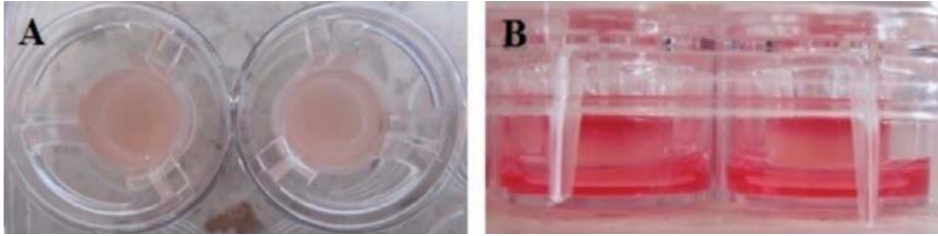
Figure 1- (cid:36)(cid:17)(cid:3)(cid:36)(cid:76)(cid:85)(cid:16)(cid:79)(cid:76)(cid:84)(cid:88)(cid:76)(cid:71)(cid:3)(cid:87)(cid:72)(cid:70)(cid:75)(cid:81)(cid:76)(cid:84)(cid:88)(cid:72)(cid:3)(cid:83)(cid:75)(cid:68)(cid:86)(cid:72)(cid:3)(cid:20)(cid:29)(cid:3)(cid:39)(cid:72)(cid:89)(cid:72)(cid:79)(cid:82)(cid:83)(cid:80)(cid:72)(cid:81)(cid:87)(cid:3)(cid:82)(cid:73)(cid:3)(cid:86)(cid:87)(cid:85)(cid:82)(cid:80)(cid:68)(cid:3)(cid:90)(cid:76)(cid:87)(cid:75)(cid:3)(cid:87)(cid:75)(cid:72)(cid:3)(cid:191)(cid:69)(cid:85)(cid:76)(cid:81)(cid:18)(cid:68)(cid:74)(cid:68)(cid:85)(cid:82)(cid:86)(cid:72)(cid:3)(cid:74)(cid:72)(cid:79)(cid:86)(cid:17)(cid:3)(cid:37)(cid:17)(cid:3)(cid:54)(cid:83)(cid:72)(cid:70)(cid:76)(cid:191)(cid:70)(cid:3)(cid:70)(cid:88)(cid:79)(cid:87)(cid:88)(cid:85)(cid:72)(cid:3)(cid:80)(cid:72)(cid:71)(cid:76)(cid:88)(cid:80)(cid:3)(cid:83)(cid:79)(cid:68)(cid:70)(cid:72)(cid:71)(cid:3)(cid:76)(cid:81)(cid:3)(cid:68)(cid:3) Transwell System in accordance with the air-liquid technique